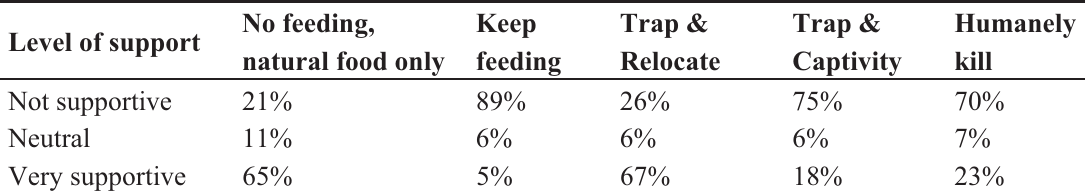
Table 2. Percentage of respondents in the first survey expressing different levels of support for post-hibernation management options for the food-conditioned bears a